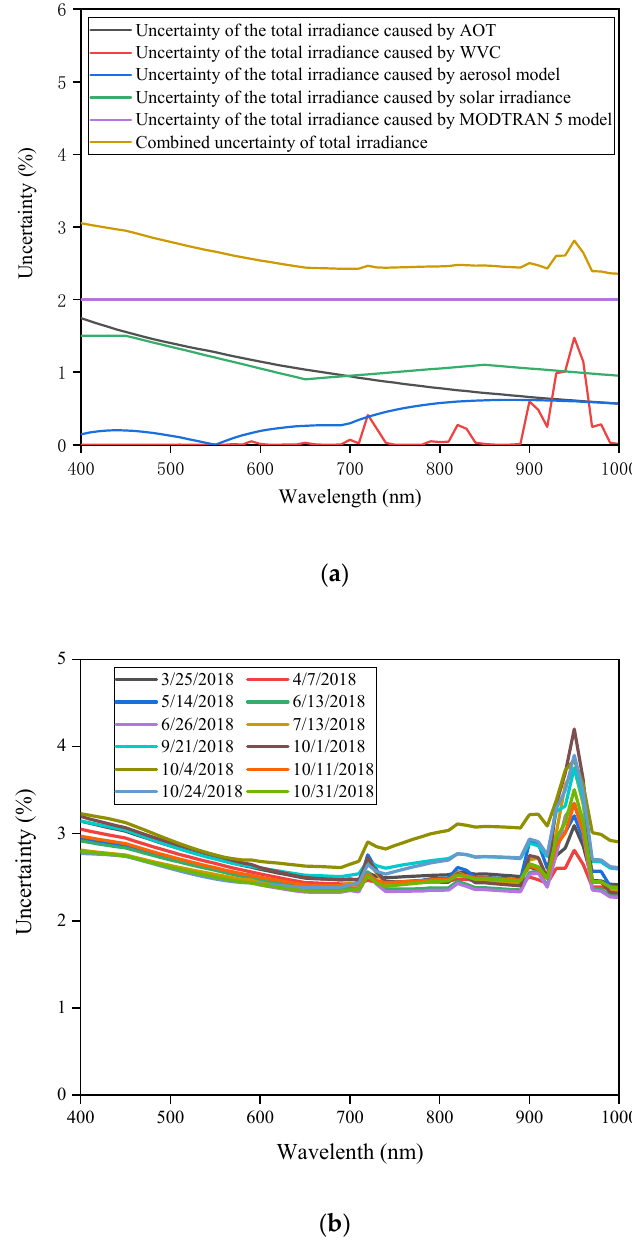
Figure 10. The combined uncertainty of the total irradiance arriving at the ground covering 400 nm to 1000 nm on the study dates. ( a ) Uncertainties of total irradiance caused by WVC, AOT, aerosol types, solar irradiance, and the MODTRAN 5 model on 7 April 2018; ( b ) uncertainties of total irradiance on the study dates.